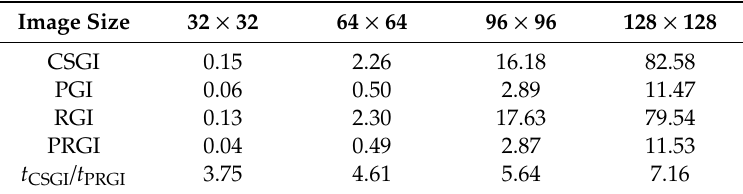
Table 1. Time cost(s) of the four methods under di ff erent image sizes. Image Size 32 ×